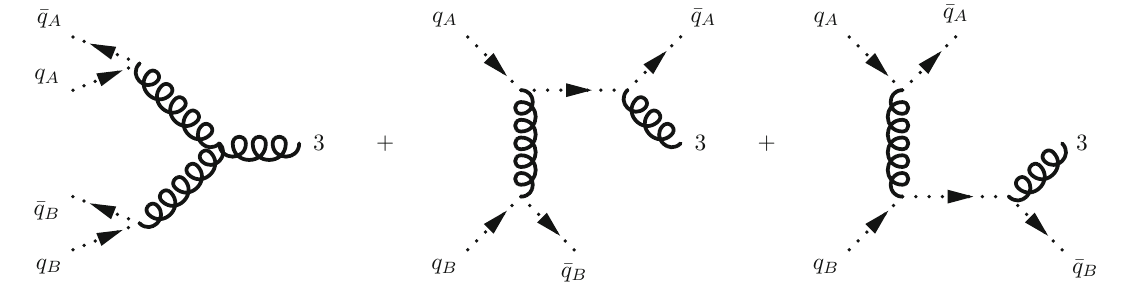
Fig. 4 Feynman diagrams contributing to A ( 1 ∗ , 2 ∗ , 3 ± ) . Note that we have only three diagrams instead of the usual five diagrams found in the derivation of the Lipatov vertex. This is merely due to color ordering imposed on the helicity amplitudes and does not affect the final